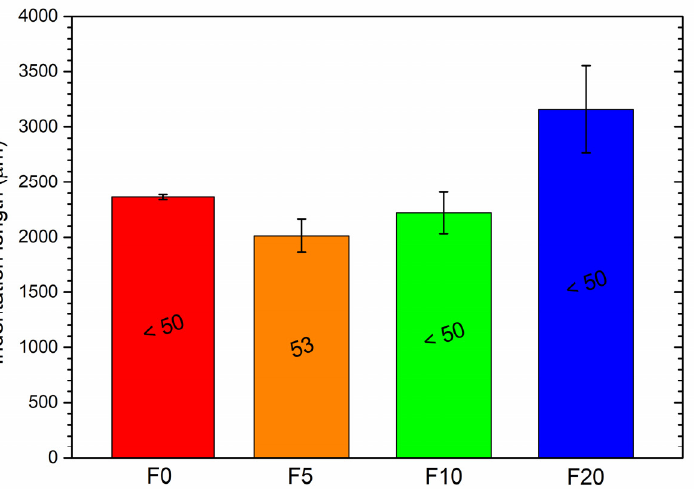
Figure 11. Evolution of the indentation length of the Buchholz test notches, with the corresponding Buchholz hardness values.